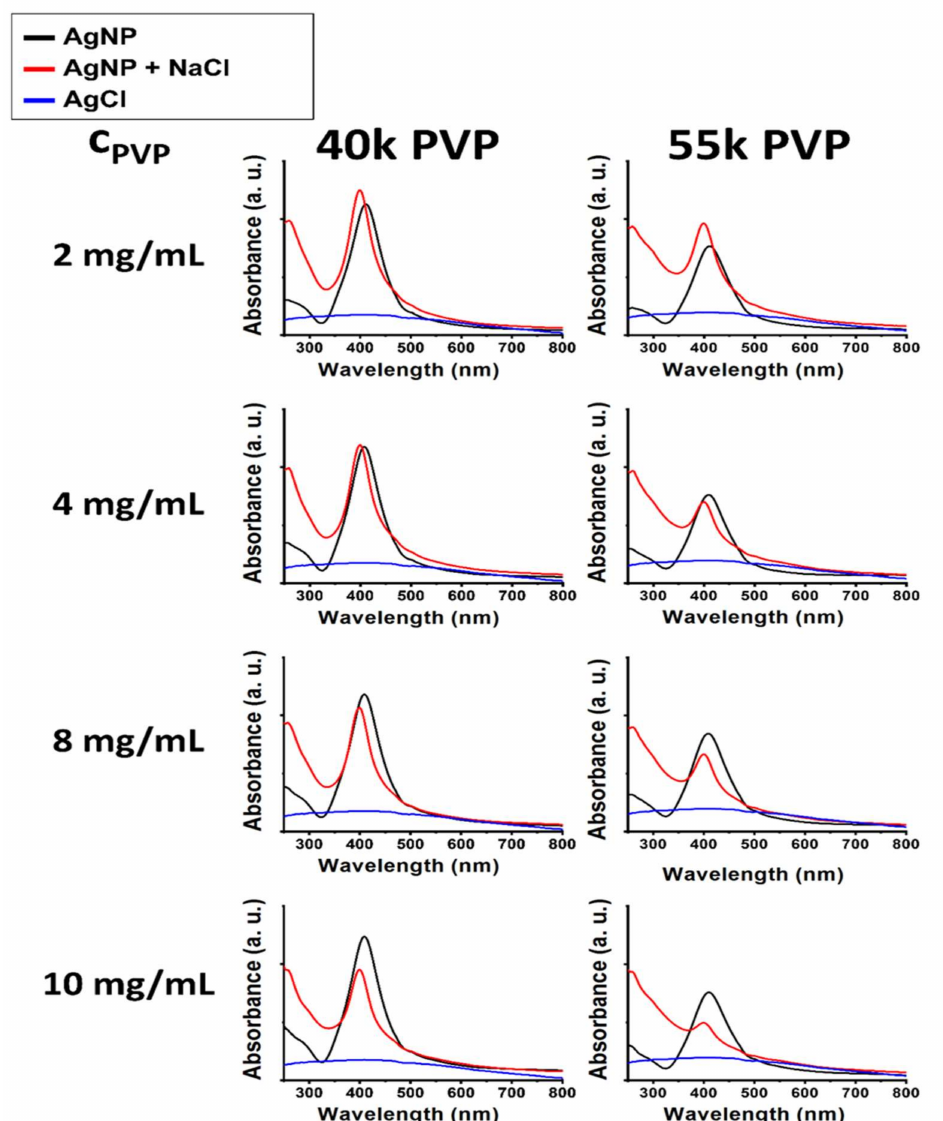
Figure 2. UV–Vis spectra demonstrating the chemical degradation of 40k (left panels) and 55k (right panels) molecular weight PVP-stabilized silver nanoparticles through AgCl precipitation induced by incubation with 100 mM NaCl for 20 h under various PVP concentrations (indicated on the left side of the